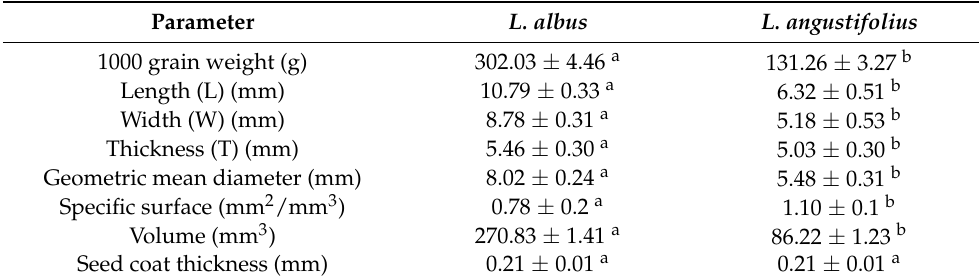
Table 1. Physical properties of L. albus and L. angustifolius